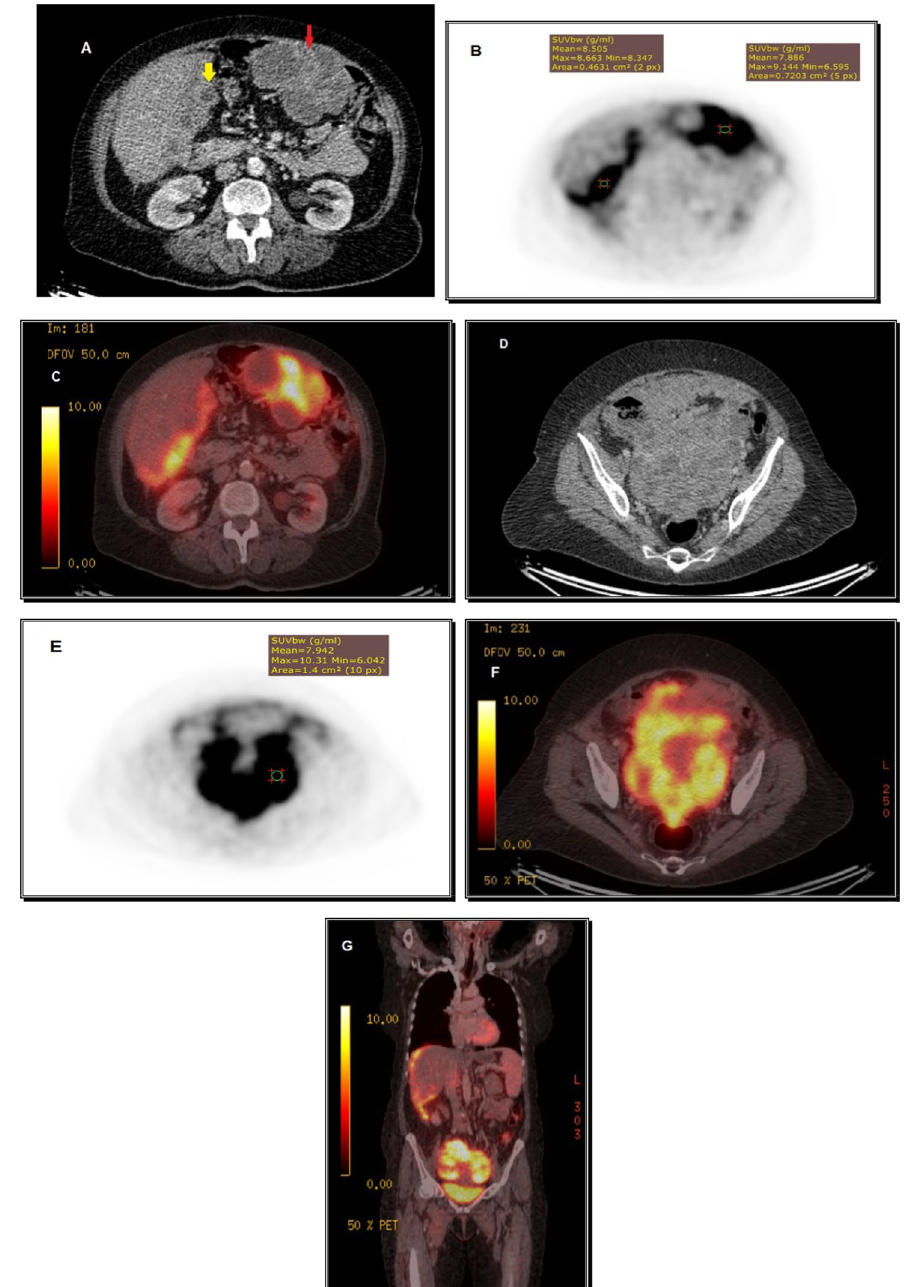
Fig. 6 A 65-year-old female patient with a history of ovarian cancer pathologically proven ovarian mucinous cystadenocarcinoma, referred for whole body survey A Axial contrast-enhanced CT. B Axial PET slice at the same level. C Corresponding axial fused PET/CT image, showing Intense metabolically active multiple hypodense peritoneal nodules creeping along and indenting the inferior and lateral serosal surfaces of the liver, the largest is resting upon the gall bladder fossa (yellow arrow) in addition to left hypochondrial enhancing soft tissue mass lesion showing areas of internal breaking down underneath anterior abdominal wall inseparable from bowel serosa (red arrow), both eliciting SUV max ~ 8.6 and 9.1, respectively. D Axial contrast-enhanced CT. E Axial PET slice at the same level. F Corresponding axial fused PET/CT image, showing bilateral adnexal heterogeneously enhancing large solid mass lesions with areas of breaking down, almost totally occupying the pelvic cavity with significant mass effect upon the surroundings, inseparable from the uterus, posteriorly infiltrating the recto-sigmoid colon and upper rectum and resting upon the urinary bladder, eliciting SUVmax ~ 10. G Coronal PET/CT image demonstrating intense FDG diffuse liver surfaces uptake in addition to the pelvic = soft tissue mass lesion seen resting upon the urinary